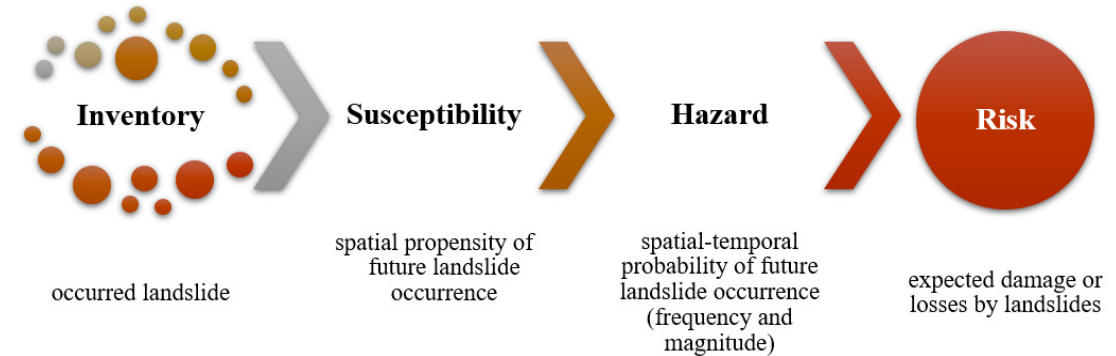
Figure 1. Levels of landslide mapping derived from Van Westen [21].